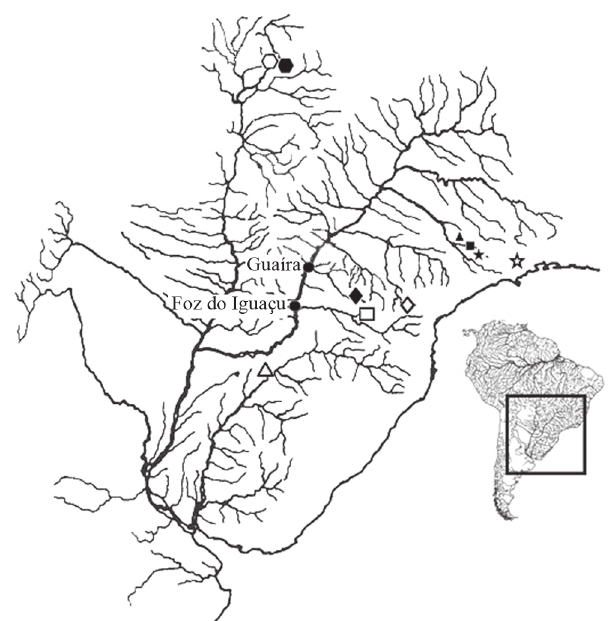
Fig. 1. Map of the La Plata River basin showing the localities of Parodontidae samples used in this study. Empty